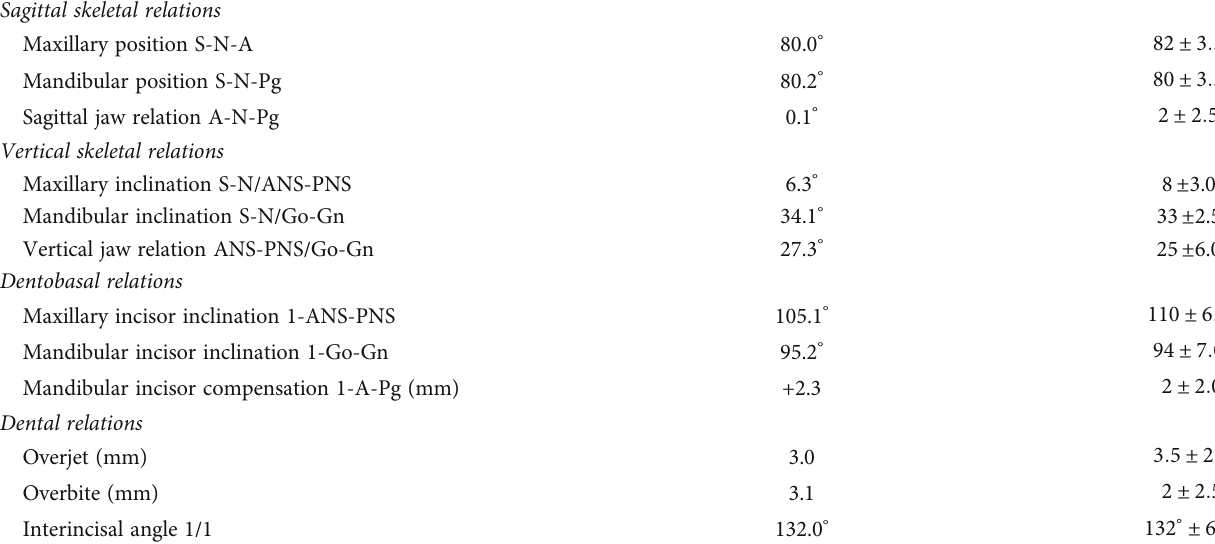
Table 3: Cephalometric values 2 years after the end of treatment.